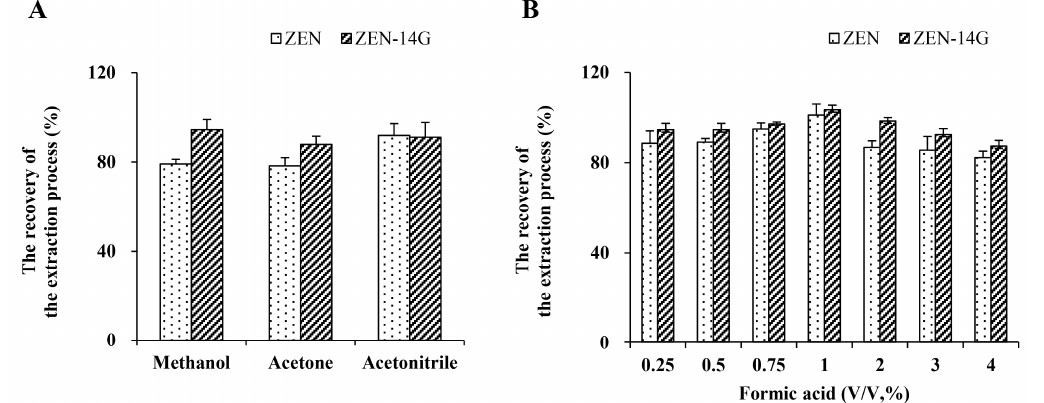
Figure 2. The extraction efficiencies of zearalenone (ZEN) and zearalenone-14-glucoside (ZEN-14G) by three candidate solvents ( A ) and acetonitrile containing different contents of formic acid (0.25–4%, v / v ) ( B ) were compared. The concentration is 50 µg/L. Acceptable recovery rates are between 70% and 120%.